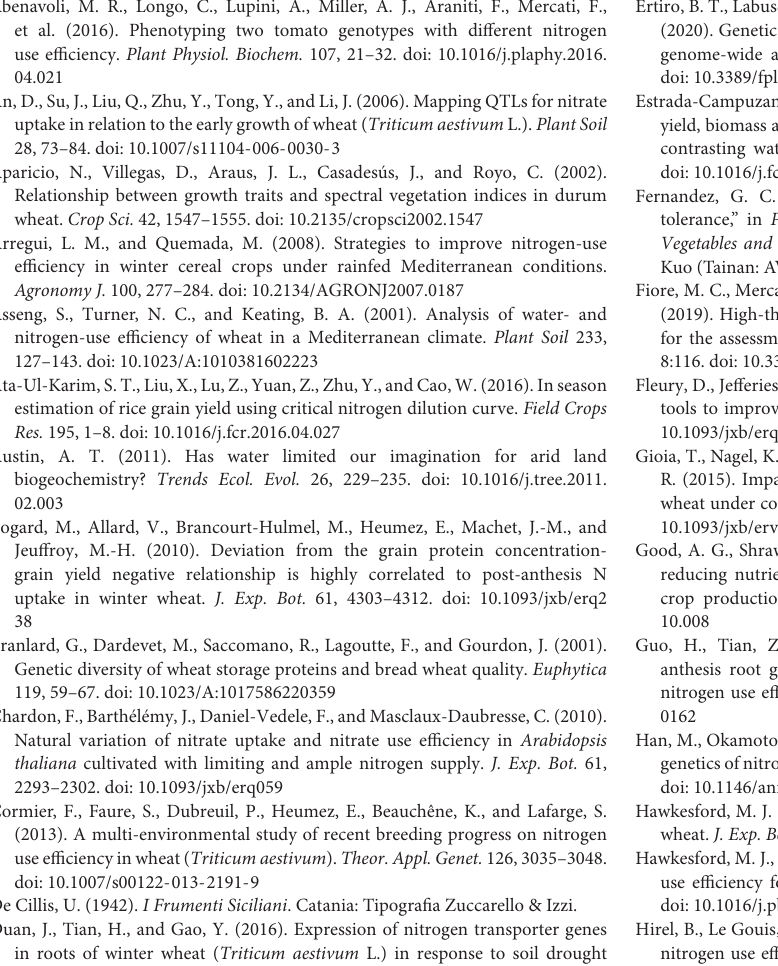
Supplementary Figure 4 | Pearson’s correlation between water use efficiency and nitrogen use efficiency at low and high N level for each genotype. Supplementary Table 1 | List of genotypes employed in the present study and pedigree origin. Supplementary Table 2 | Forward and reverse primers for gene amplification in real-time